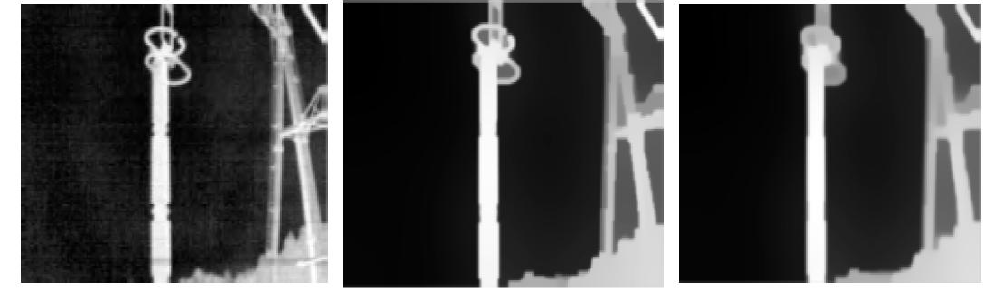
Fig. 3. Influence of deviation parameters σ on filter